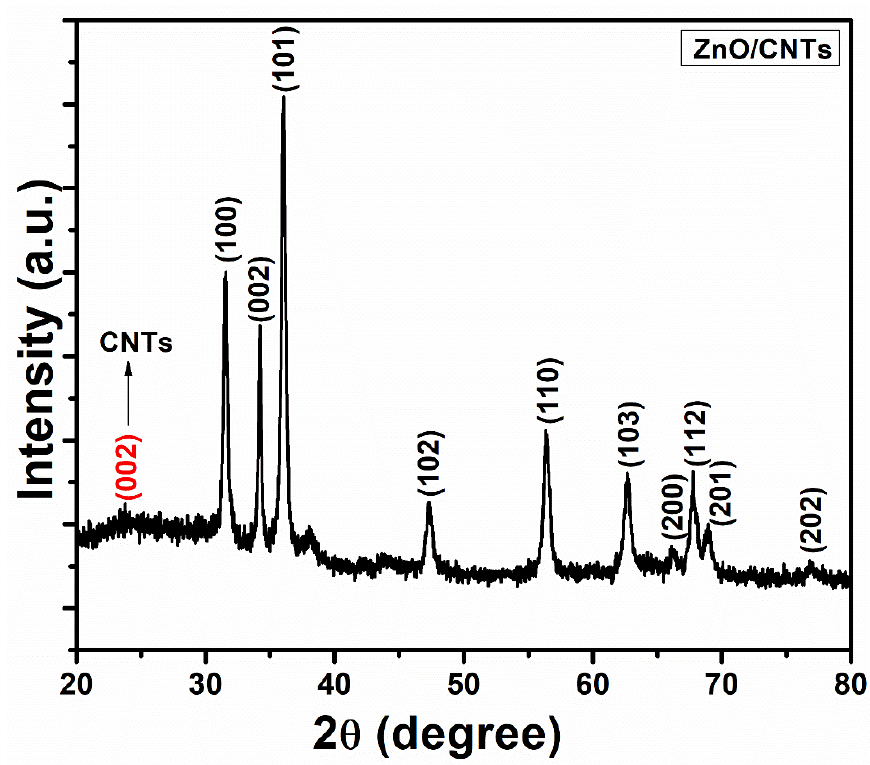
Figure 3. XRD patterns of ZnO/CNTs nanocomposites.